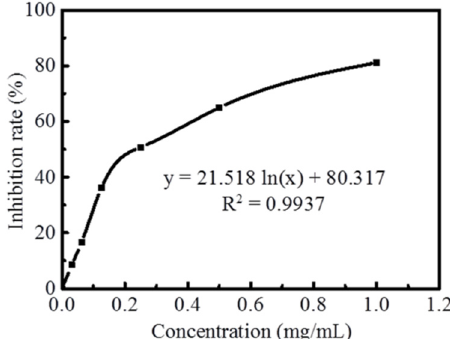
Figure 4. The inhibition rate of total flavonoids to tyrosinase.